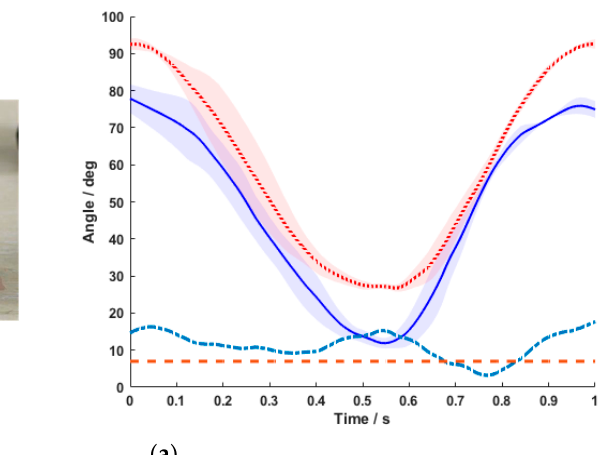
Table 2. Root Mean Squared Errors (RMSE) for all subjects in each test